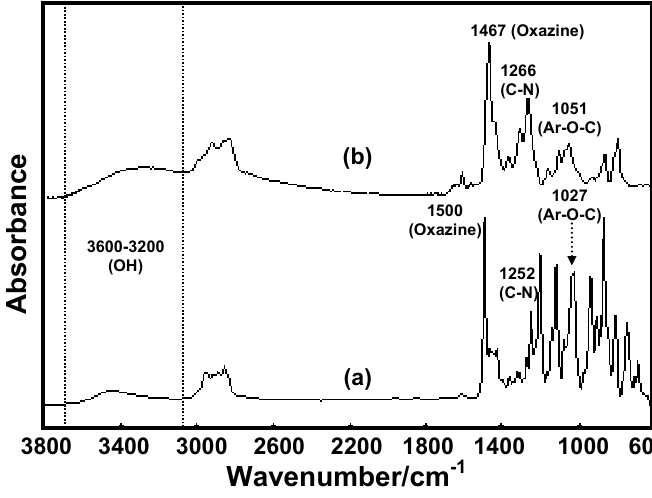
Figure 9. FTIR spectra of (a) BM1 and (b) Ce(III)- BM1